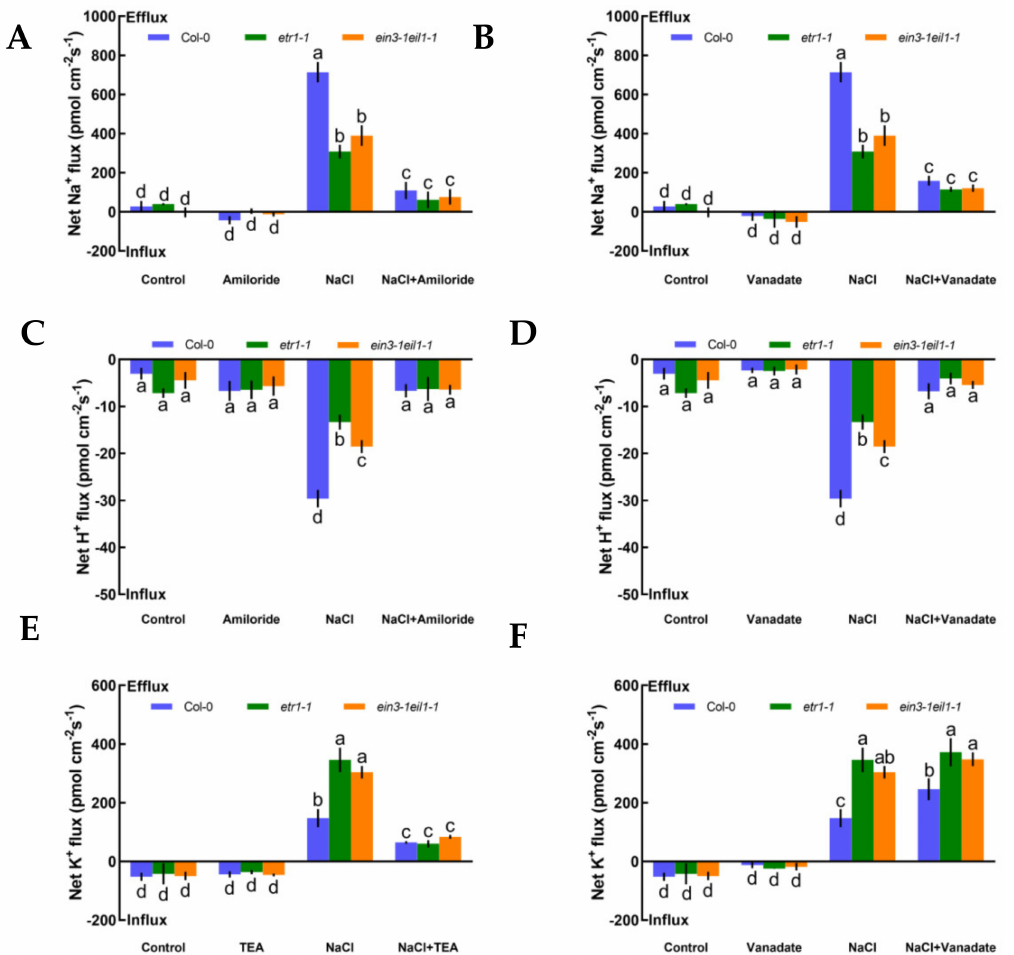
Figure 3. Pharmacological e ff ects of amiloride (50 µ M), sodium orthovanadate (500 µ M), and tetraethylammonium (TEA, 50 µ M) on the steady-state Na + , K + , and H + flux kinetics in Col-0, etr1-1 , and ein3-1eil1-1 roots under short-term NaCl stress (100 mM, 12 h). Young roots were cultured in MS medium without ( − NaCl) or with NaCl (100 mM) for 12 h, then subjected to treatment with ion channel-related inhibitors for 30 min prior to the determination of flux kinetics. Salt-elicited Na + ( A , B ), H + ( C , D ), and K + ( E , F ) flux kinetics were recorded at the meristem root zones (500 µ m from the root apex) in the absence (left) and presence (right) of ion channel-related inhibitors for 15 min. Each column ( ± SD) represents the mean of five to six individual plants and the letters a, b, c, and d denote significant di ff erences between di ff erent treatments ( p <